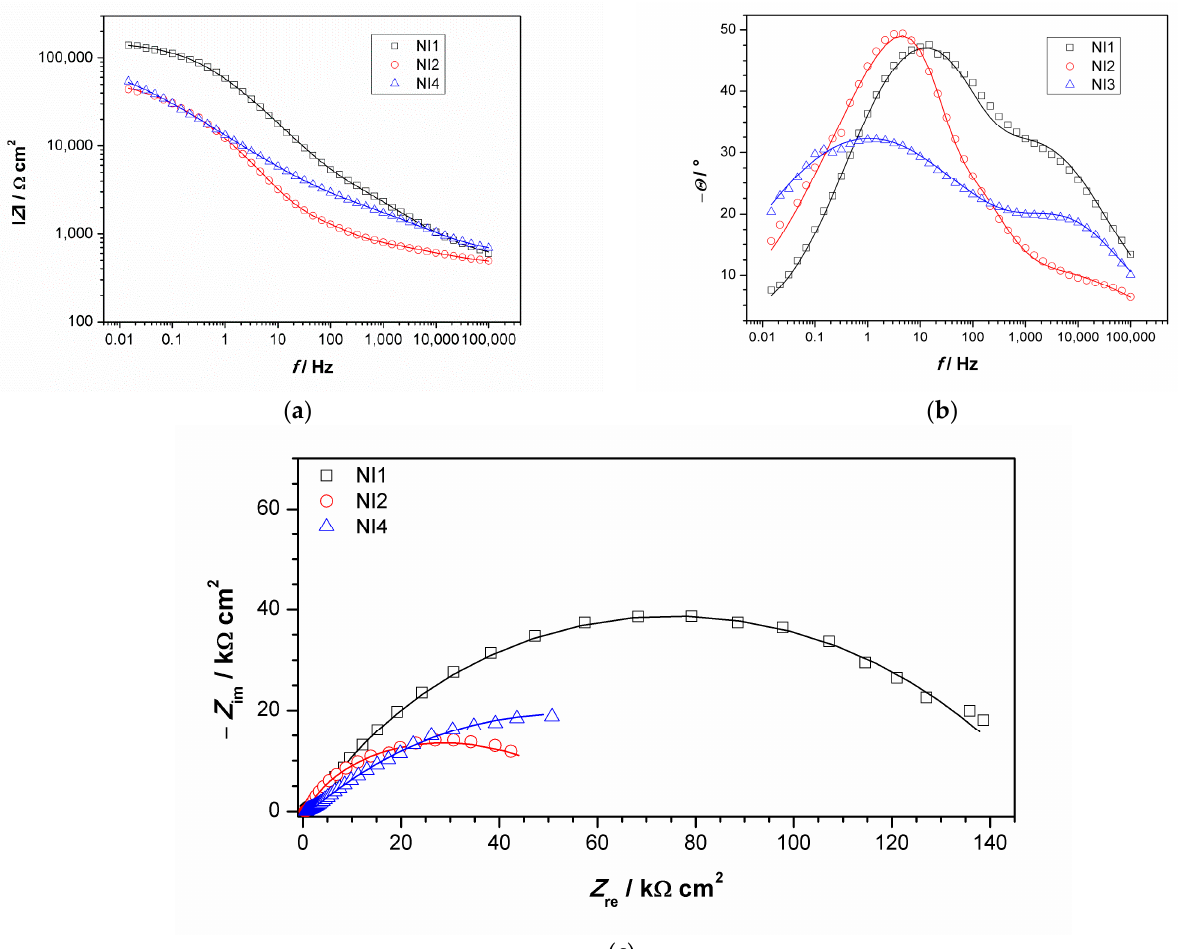
Figure 9. Impedance spectra obtained on NI: ( a ) impedance modulus Bode plot, ( b ) phase angle Bode plot, and ( c ) Nyquist plot. Symbols represent measured and lines fitted data.